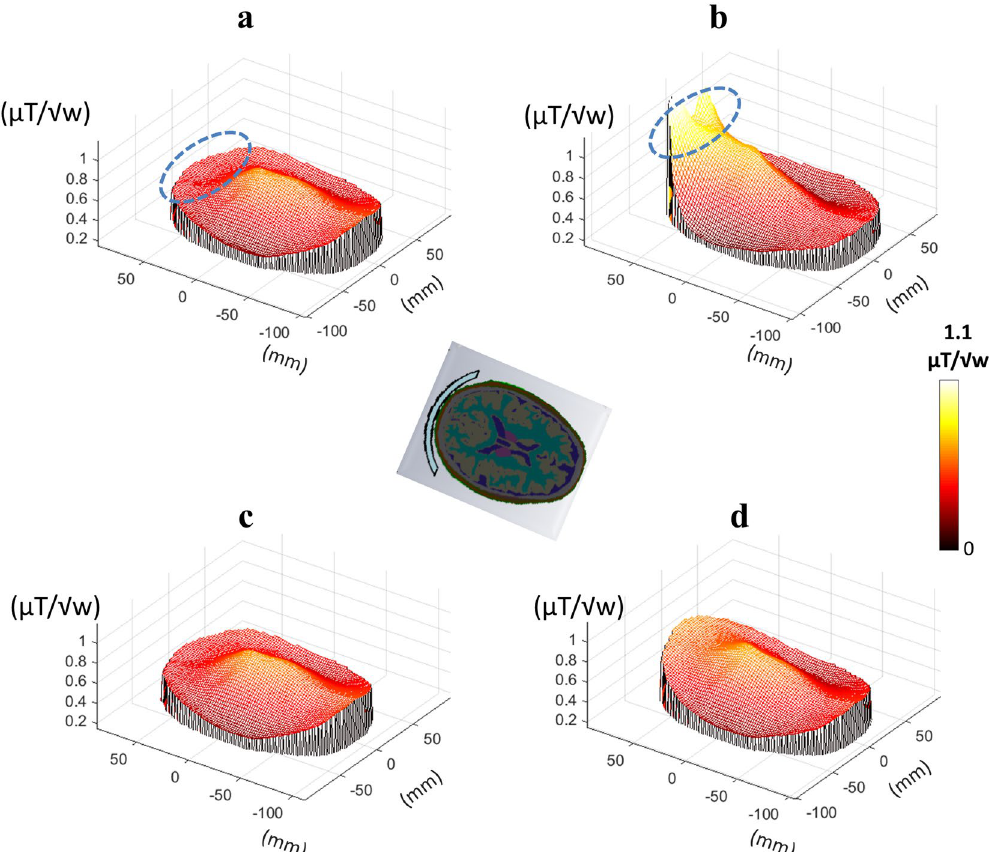
Figure 3. EM simulations of the human head showing mesh plots of the B 1 + distribution along a central axial cross-section of the brain for the following setups: ( a ) no structure, ( b ) with metasurface tuned to 298 MHz, ( c ) with metallic strips only and ( d ) with the dielectric substrate only. The axial cross section of the brain and the metasurface location (in blue) is shown in the centre. The blue dashed ellipse shows the region of interest in the occipital